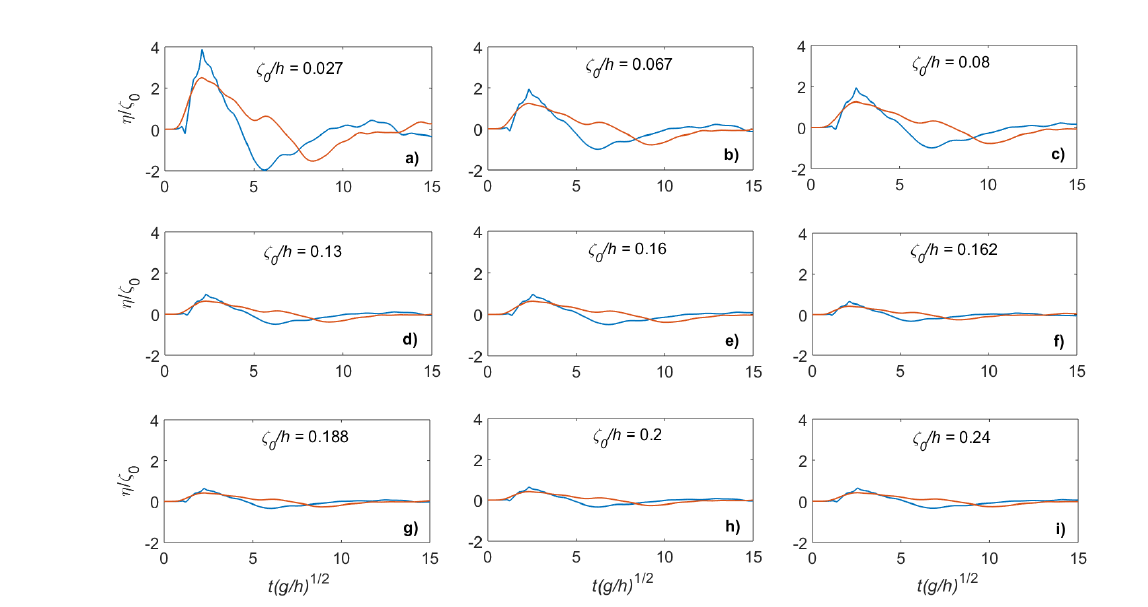
Figure 10. Dimensionless surface elevations as a function of dimensionless time at WG1 (blue) and WG2 (red) for an inclined uplift-only